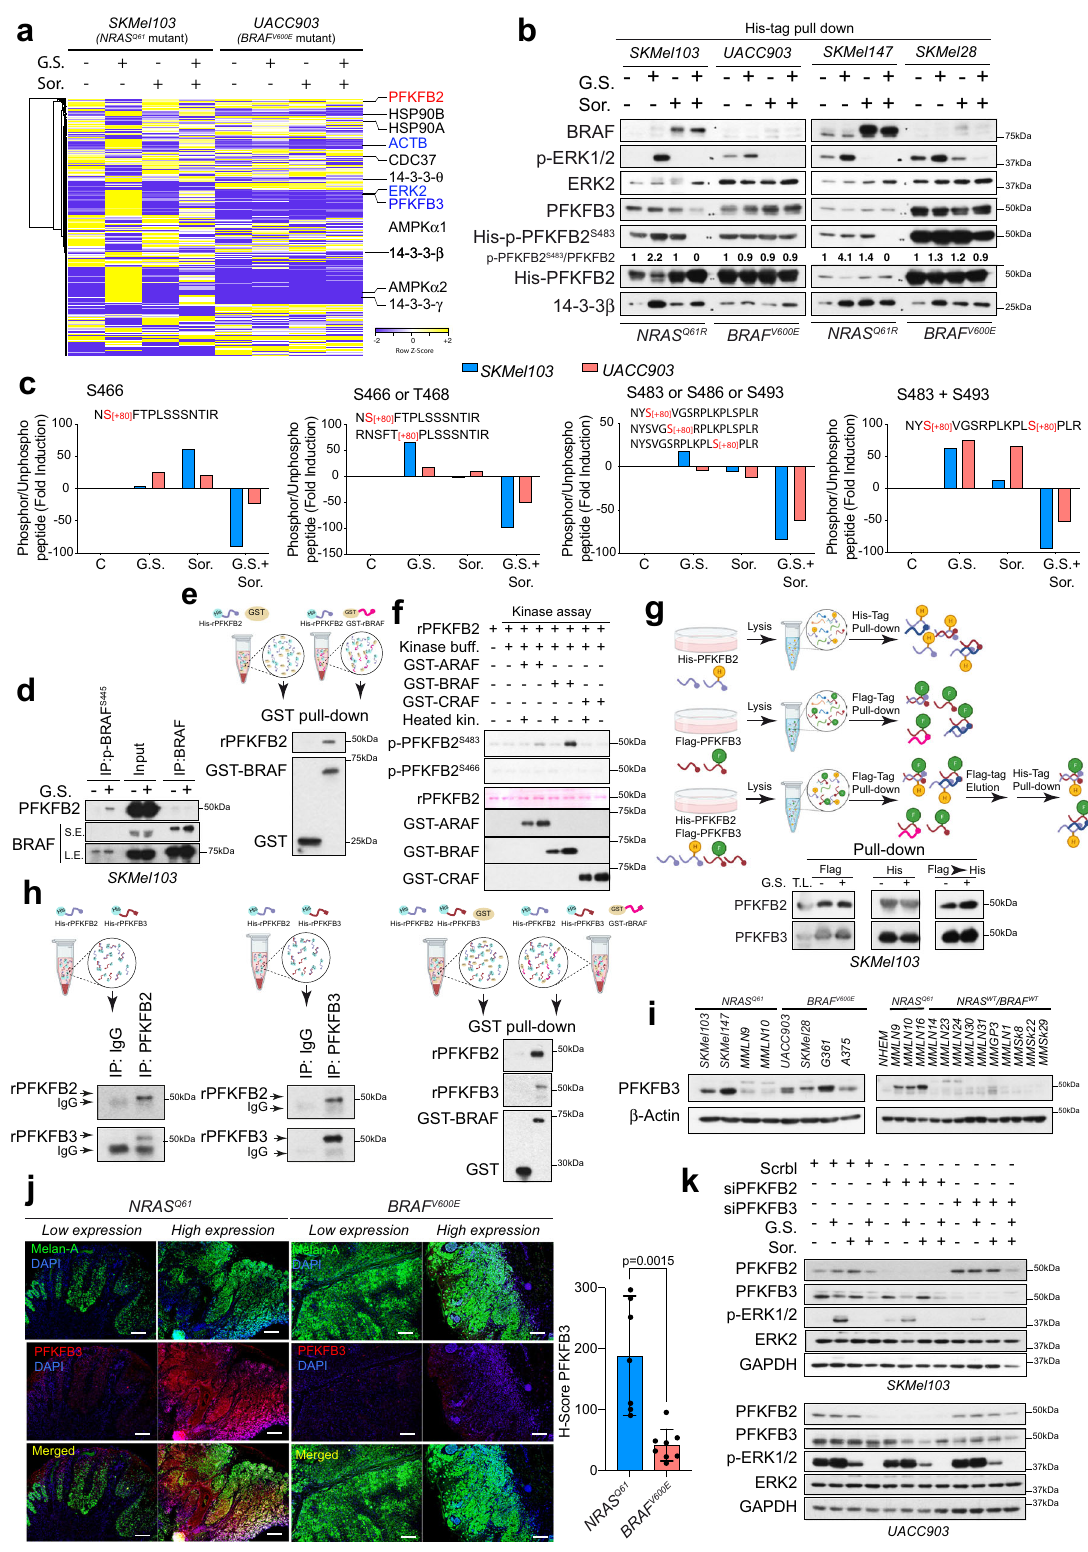
cobalt-based immobilized metal af fi nity chromatography (IMAC) Dynabeads TM following the manufacturer ’ s directions (Thermo Fisher Scienti fi c). Eluted His-tagged proteins were used for immunoblotting or mass spectrometry. To pull down Flag-tagged proteins, an anti-Flag M2 Af fi nity Gel Kit (Thermo Scienti fi c) was used following the manufacturer´s instructions. After binding and